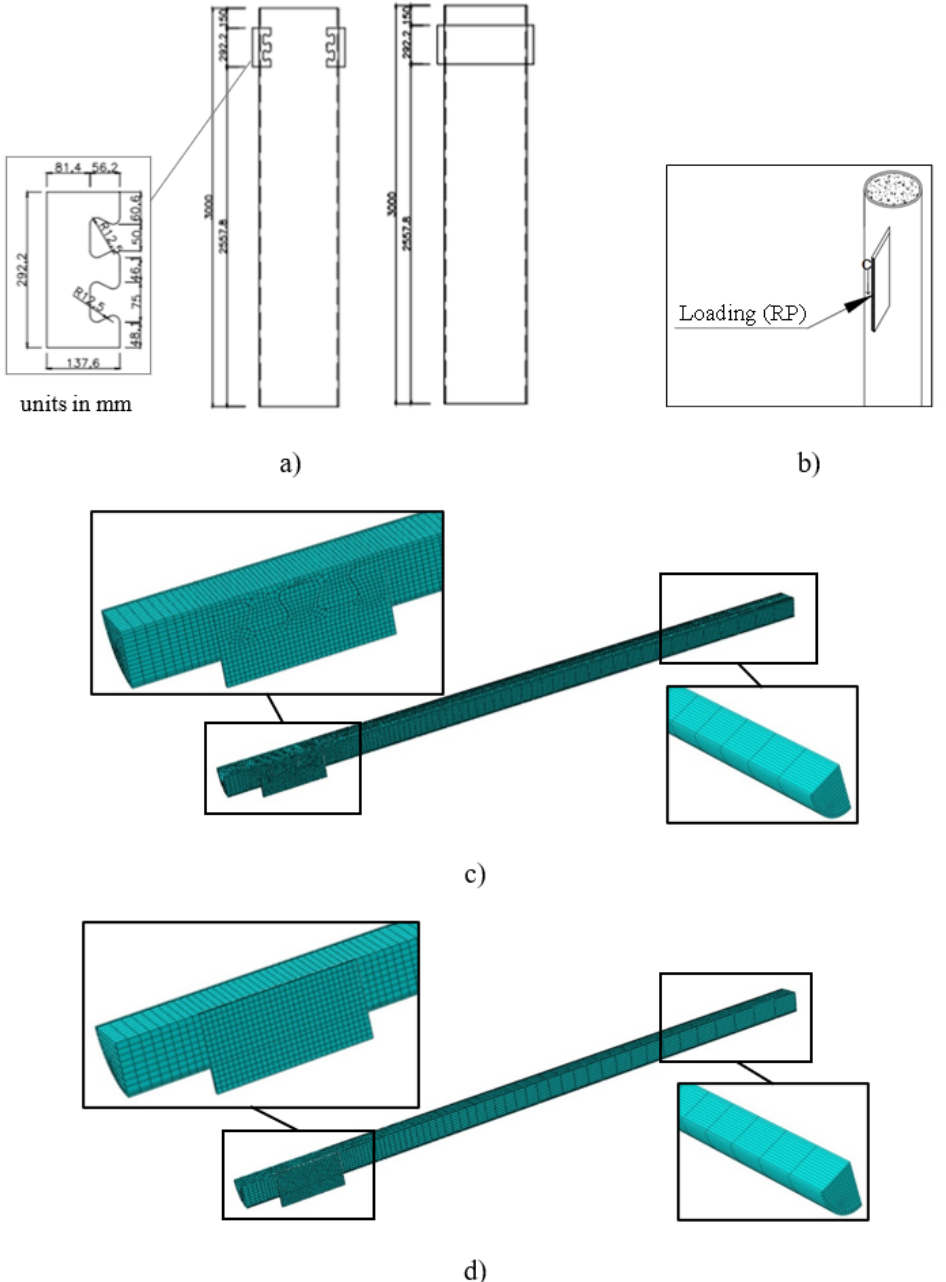
Figure 7. Details of a) CFCC with Crestbond and Shear Flat, b) loading point, c) Crestbond FE model and d) Shear Flat FE